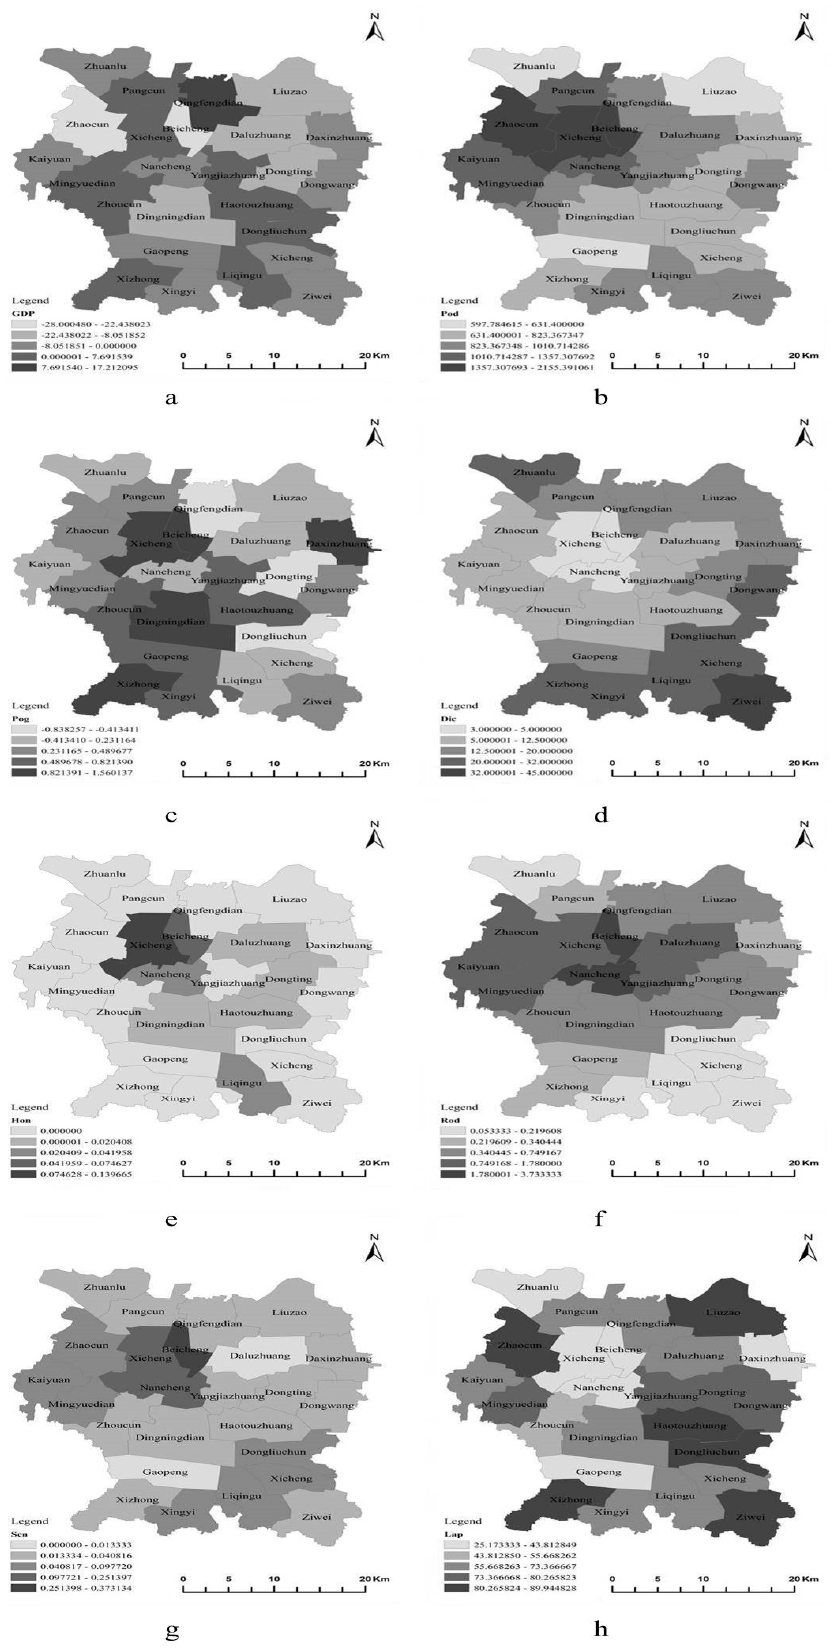
Figure 3. Spatial distribution of the eight impact factors. ( a ) GDP; ( b ) Pod; ( c ) Pog; ( d ) Dic; ( e ) Hon; ( f ) Rod; ( g ) Scn; ( h ) Lap.